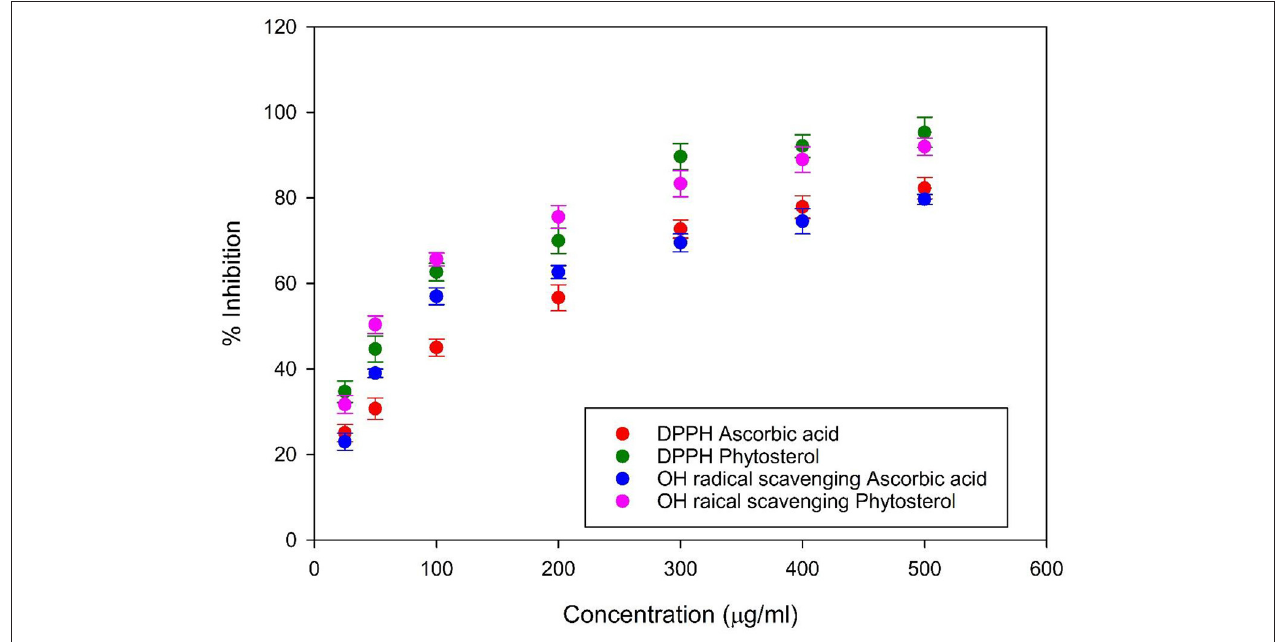
FIGURE 1 | Antioxidant activity by 1, 1-diphenyl-2-picrylhydrazyl and hydroxyl radical scavenging assay. The assay results evidence that antioxidant activity increases with the concentration of the stigmasterol, and the activity was higher than the control ascorbic acid.